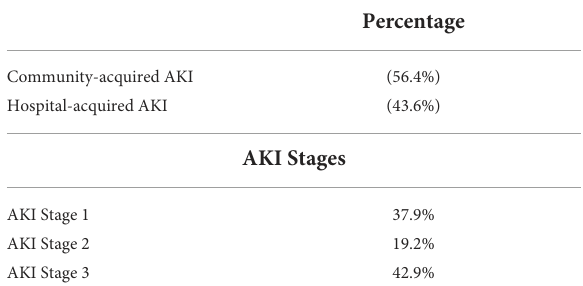
TABLE 1 Characteristics of acute kidney injury.